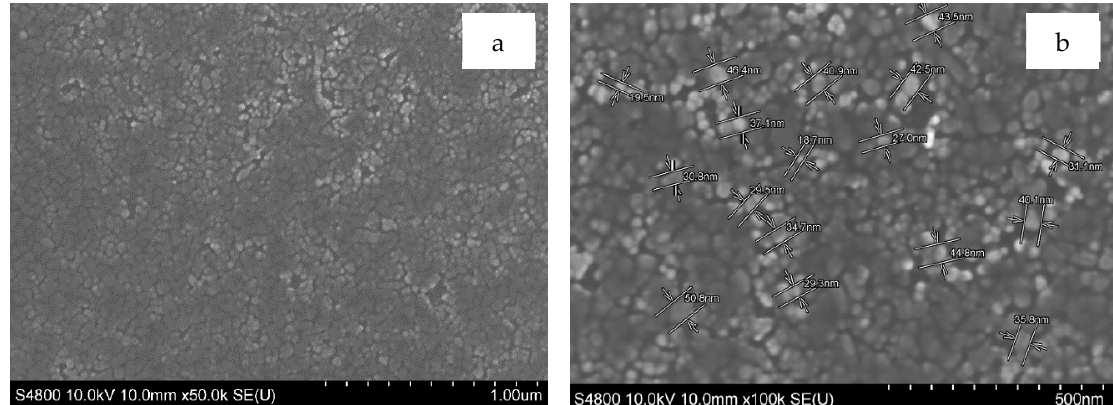
Figure 2. SEM image of ( a ) microporous ZnO thin film; ( b ) different grain sizes fabricated via MPM method.